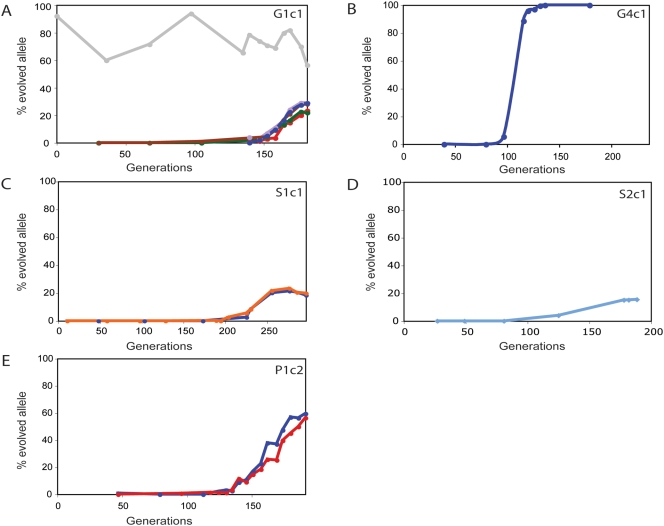
Dynamics of allele frequencies in evolving populations.We determined allele frequencies for SNPs identified at detectable frequencies in the final population sample using quantitative sequencing. (A) clone G1c1 (red, MMS2; purple, SAP185; green, GIN4; brown, BRR2; blue, CCR4; gray, PTH2), (B) clone G4c1 (blue, GSH1), (C) clone S1c1 (blue, ERG1; orange, SGF73), (D) clone S2c1 (blue, SGF73) and (E) clone P1c2 (blue, CKA2; red, SIR1). We computed fitness coefficients for clones using allele frequency estimates as estimates of clone frequencies. Fitness coefficients were calculated for each allele (Table 5) and for each clone as described in methods. Relative selection coefficients of clones are (mean±95%CI): clone G1c1 = 1.0918±0.0159, clone S1c1 = 1.0361±0.0139, clone S2c1 = 1.0247±0.0975, clone P1c2 = 1.0602±0.0081. A selection coefficient for the diploid clone G4c1 could not be computed due to the atypical allelic profile of the GSH1 mutation.